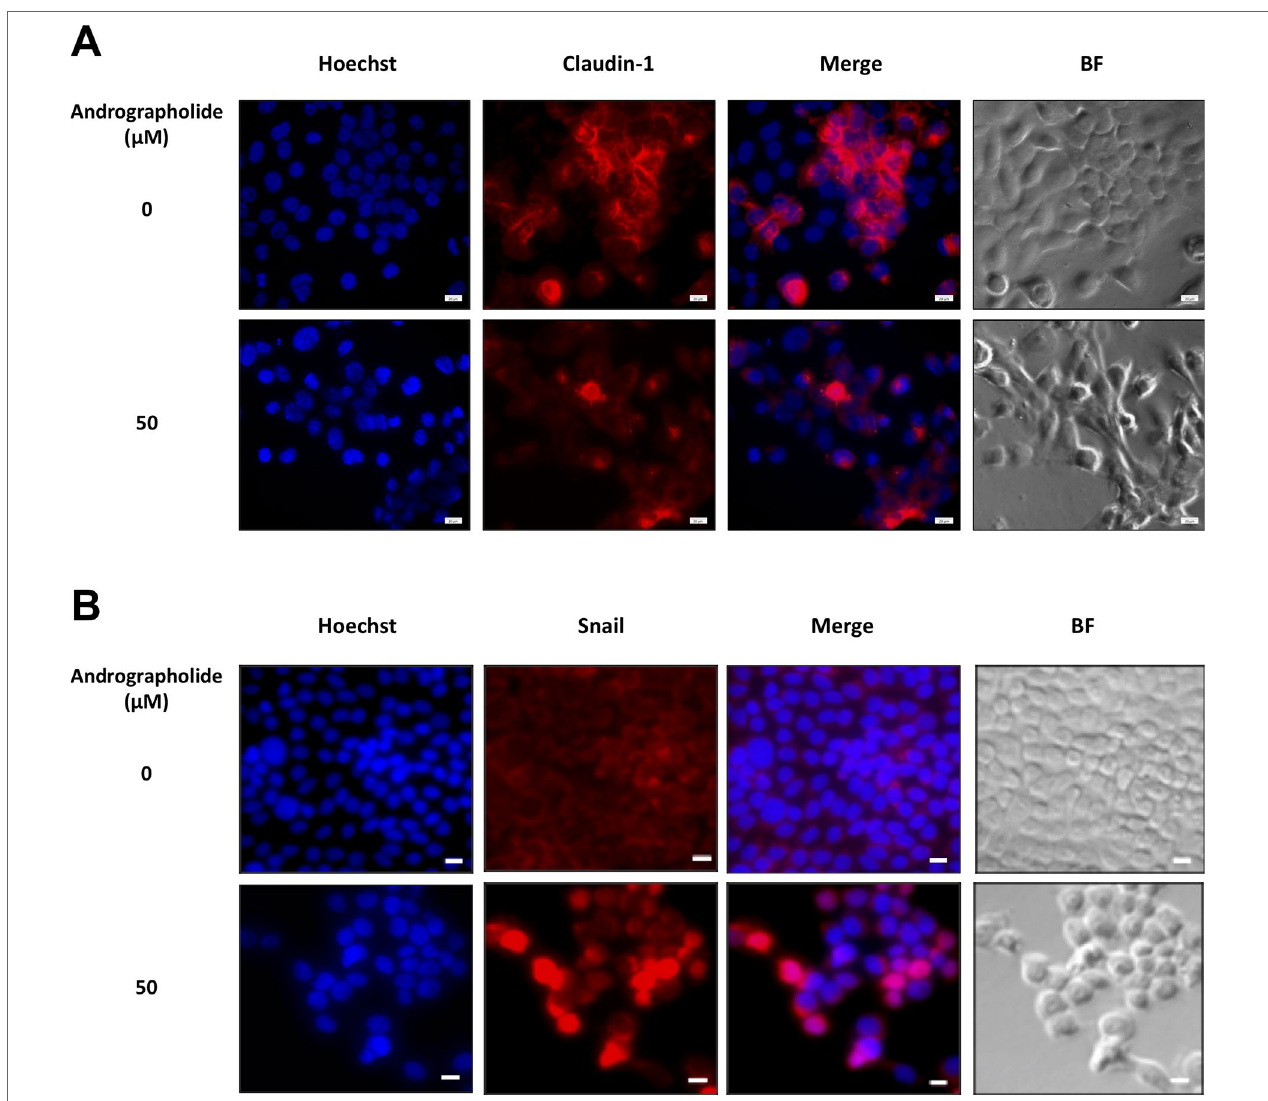
FIGURE 3 | Immunofluorescence of claudin-1 and Snail in KKU-M213 cells following andrographolide treatment. KKU-M213 cells were treated with 50 µM of andrographolide prior to fixing and staining with (A) claudin-1 and (B) snail antibodies. The control cells were treated with 1% DMSO. Anti-mouse secondary antibody conjugated with Alexa Fluor 594 was added (red). Hoechst 33342 was used as nuclei counterstain (blue). The images were obtained from Olympus IX83 inverted